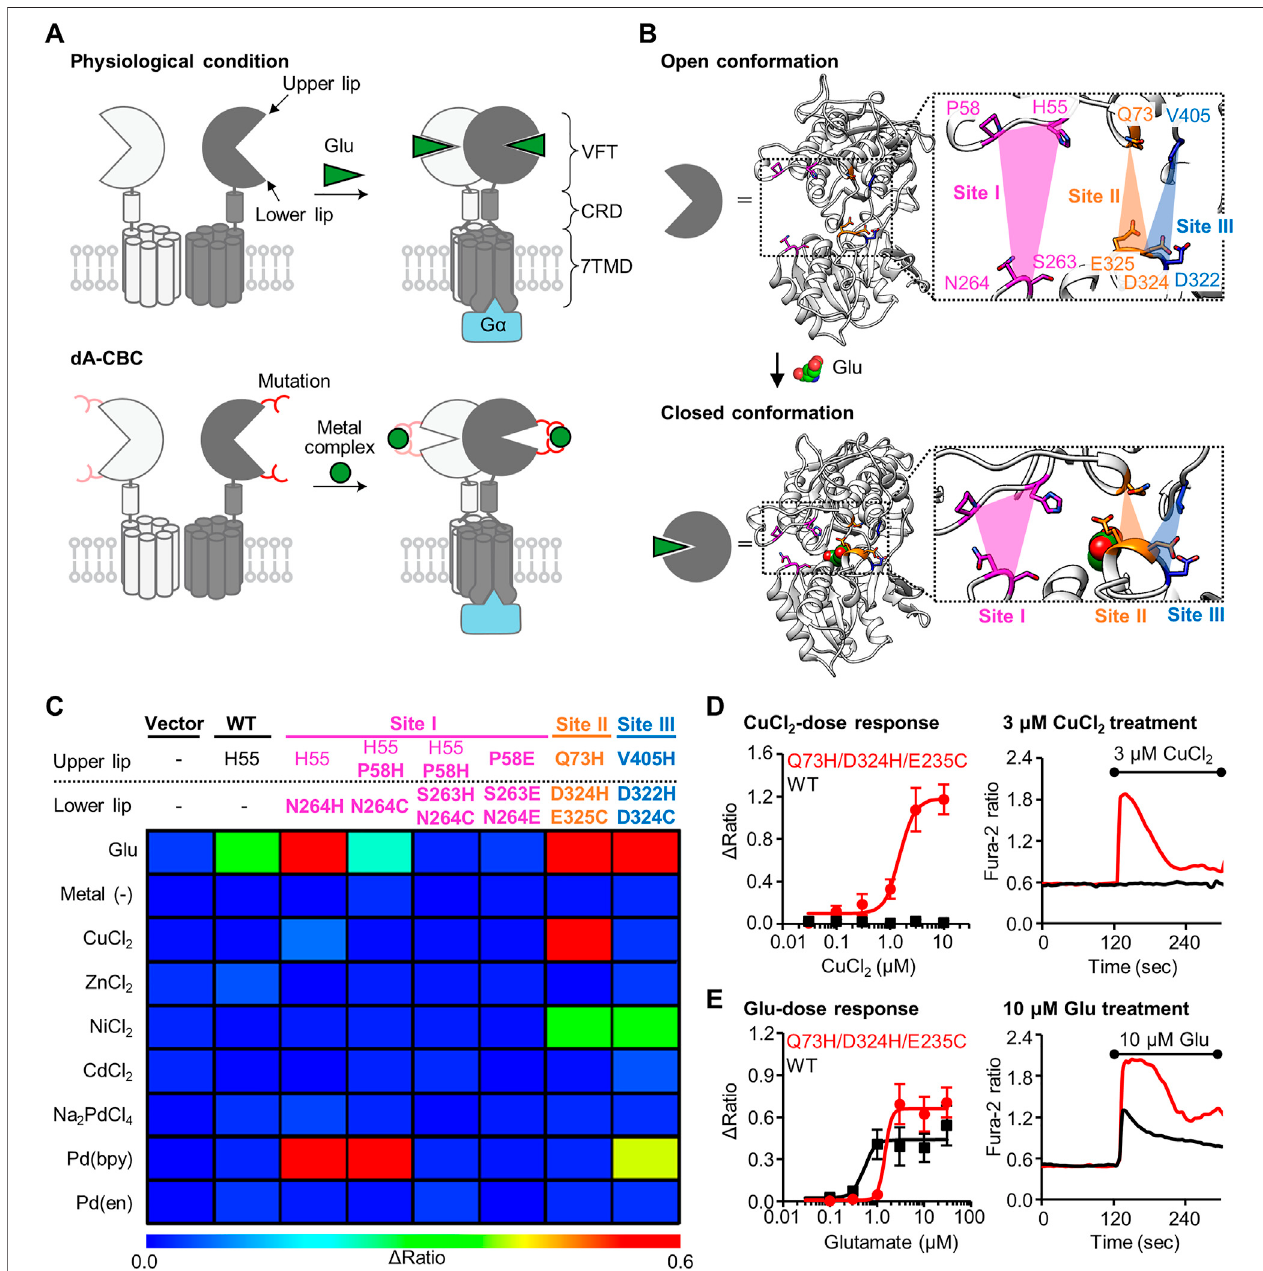
FIGURE1| ScreeningofmGlu1mutantswithsensitivitytometalionorcomplex. (A) SchematicillustrationofactivationofmGlu1inphysiologicalconditionorindA- CBC. In dA-CBC, addition of metal ion or complex induces the conformational change required for signal transduction. (B) Crystal structure of VFT domain of mGlu1 (PDB ID; 1EWT, 1EWK). Mutation sites are colored in magenta, orange, or blue, which are named Site I, Site II, or Site III, respectively. (C) Heat map of the primary screening. The heat map shows average Δ ratio values upon the addition of 10 μ M glutamate or 3 μ M each metal ion or complex. Mutation sites are described separately for upper or lower lip of VFT domain, and the mutation is shown in bold characters. See Supplementary Figure S2B for raw data. (D) Activation of the hit mutant by Cu 2+ . Left ; dose dependency of Cu 2+ -induced activation of WT mGlu1 (black) or the Q73H/D324H/E325C mutant (red). The EC 50 value of the mutant was 1.5 μ M. (n (cid:1) 11 – 15). Right ; Representative traces of CuCl 2 response asa function of time. The black bar represents theperiod when CuCl 2 was added. (E) Activation of the hit mutant by glutamate (Glu). Left ; Dose dependency of Glu-induced activation of WT mGlu1 (black) or Q73H/D324H/E325C mutant (red). The EC 50 values were 0.52or1.4 μ MforWTmGlu1orthemutant,respectively.(n (cid:1) 12 – 15). Right ;Representativetracesofglutamateresponseasafunctionoftime.Theblackbarrepresents the period when glutamate was added. Data are represented as mean ± s.e.m.